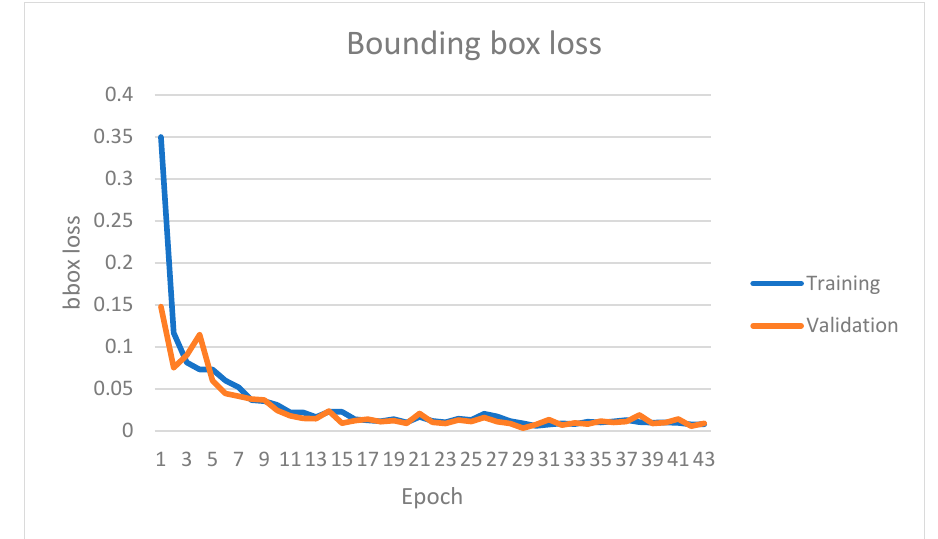
Figure 8. Instance segmentation bounding box loss on both training and validation datasets over different epochs.